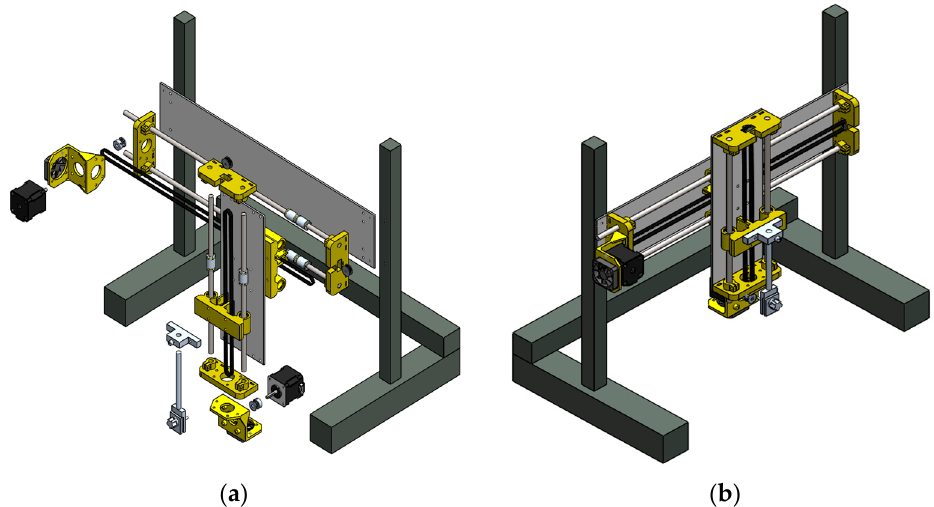
Figure 3. Design of the mechanical system of the SILAR device: ( a ) exploded view of the different mechanical elements and ( b ) view of the assembled mechanical elements.